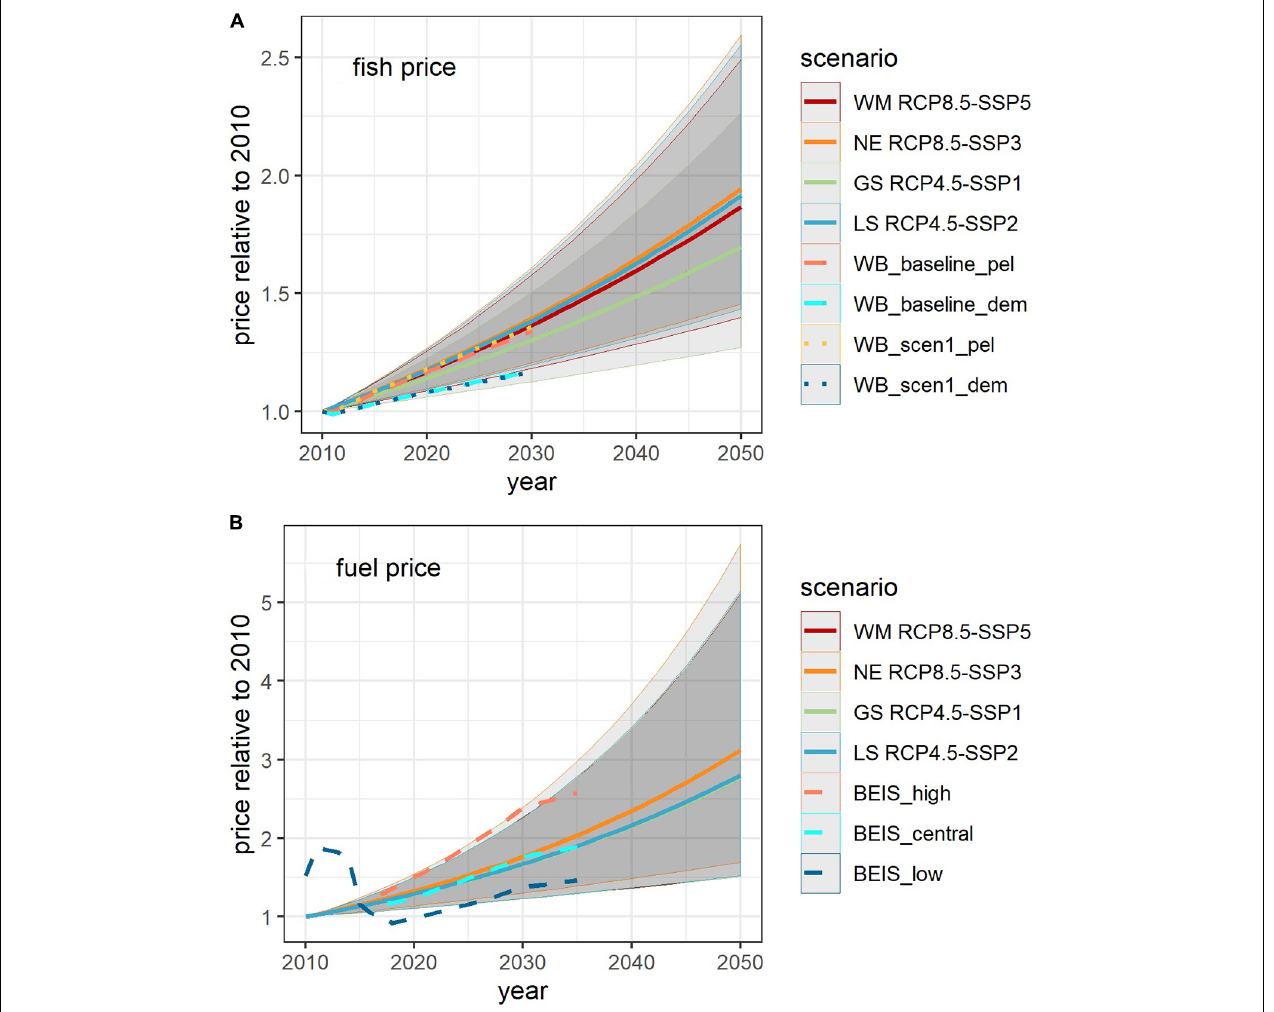
FIGURE 4 | Fish (A) and fuel (B) price trends relative to 2010 for the four CERES scenarios and for the other data sources (WB: World Bank and UK BEIS: Department for Business, Energy and Industrial Strategy). The shaded areas correspond to the 95% confidence intervals around the CERES price trend projections. In the lower panel the WM scenario is obscured by the LS and GS